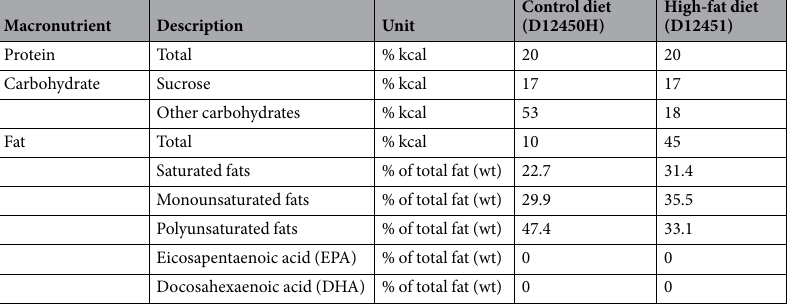
Table 1. Nutritional content of control and high-fat diets given to rat dams during pregnancy and lactation. Data have been provided by the manufacturer (Research Diets